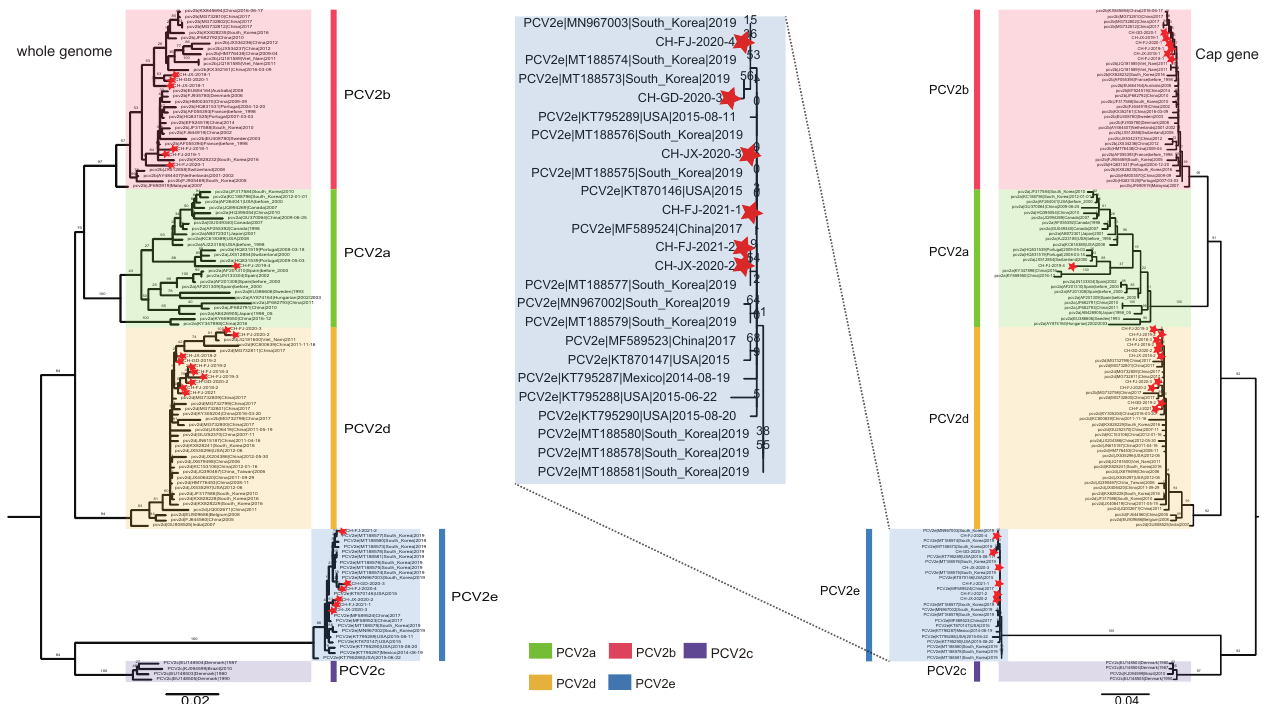
Figure 1. Maximum-likelihood (ML) trees of PCV2 whole genomes and the ORF2 gene. ML tree of PCV2 whole genomes. Scale Bar: 0.02 nucleotide substitutions per site ( left ). ML tree of the PCV2 ORF2 gene. Scale Bar: 0.04 nucleotide substitutions per site ( right ). The five-pointed stars represent the virus strains sequenced in this study. As in the prompt rectangle, different colors indicate different PCV2 genotypes.